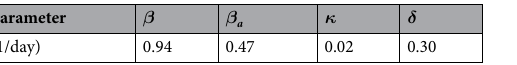
Table 4. Transition rate values used in all the simulations of the SAIS